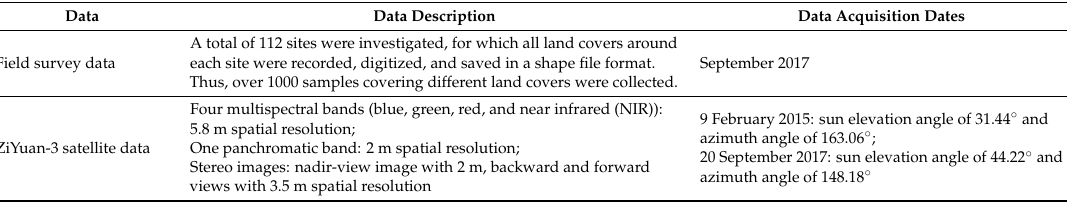
Table 1. Data used in the research.